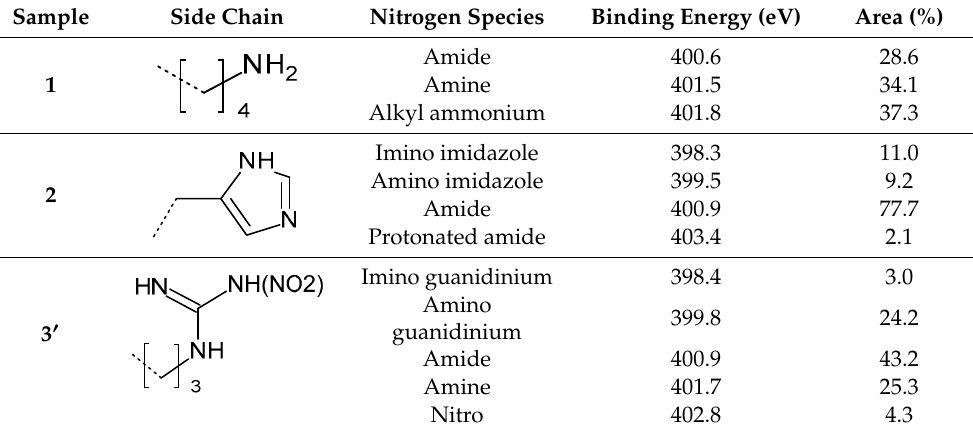
Figure 3. Deconvolution analysis of the XPS spectrum of the His-containing sample 3 . Table 3. XPS spectra and data of 1, 2 , and 3 ′ containing Lys, His, and Arg, respectively, in the 405–395 eV range.